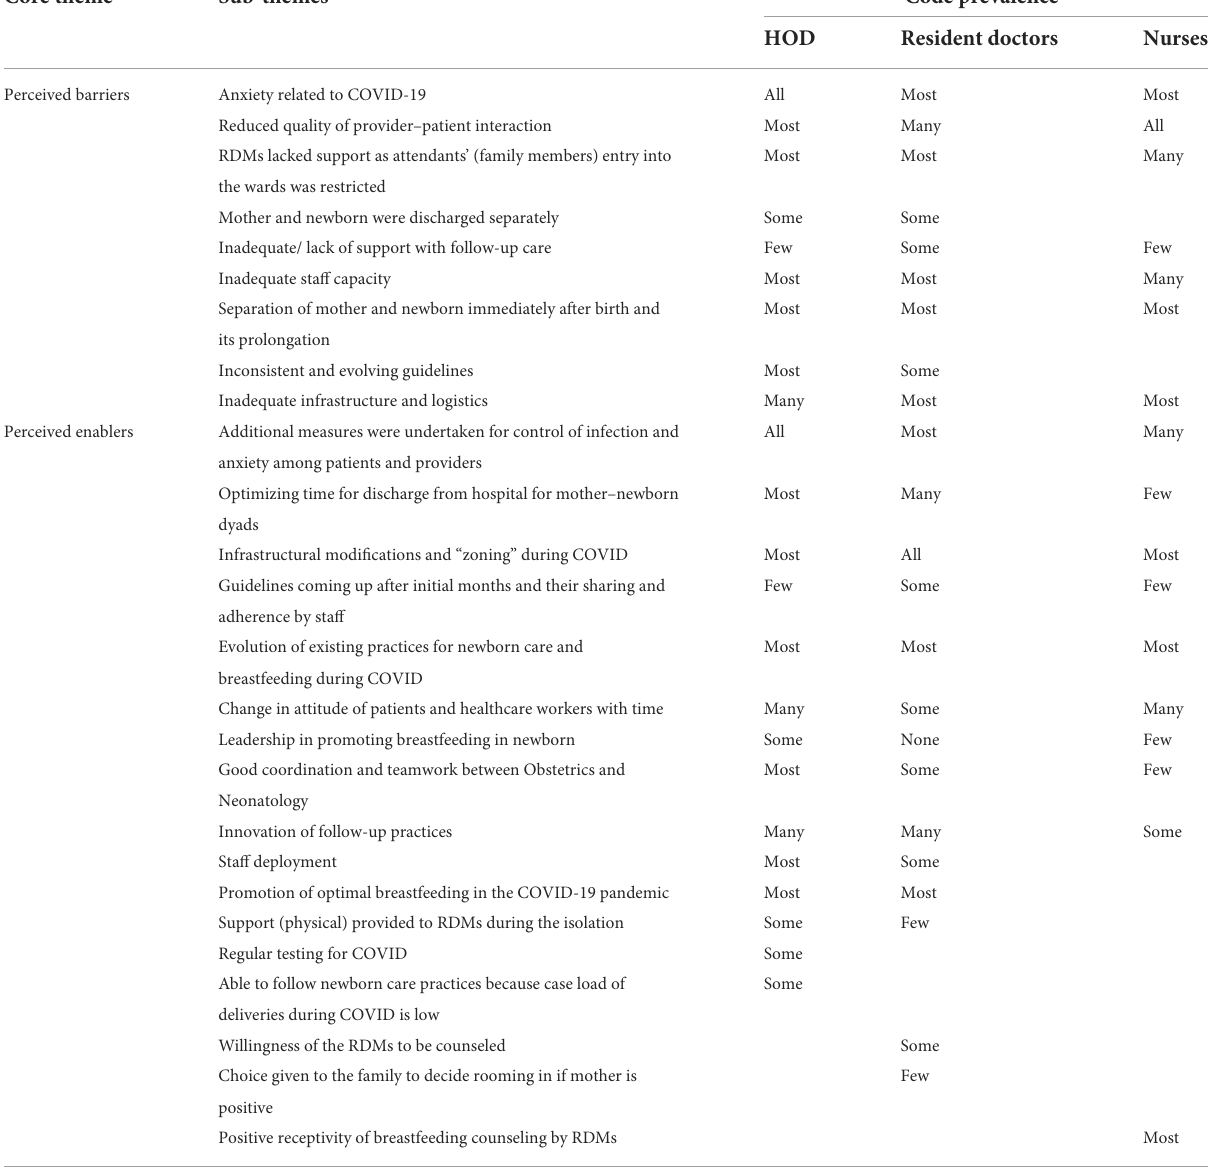
TABLE 3 List of core themes and sub-themes for optimal breastfeeding practices emerging from inductive data analysis and their code prevalence according to the healthcare